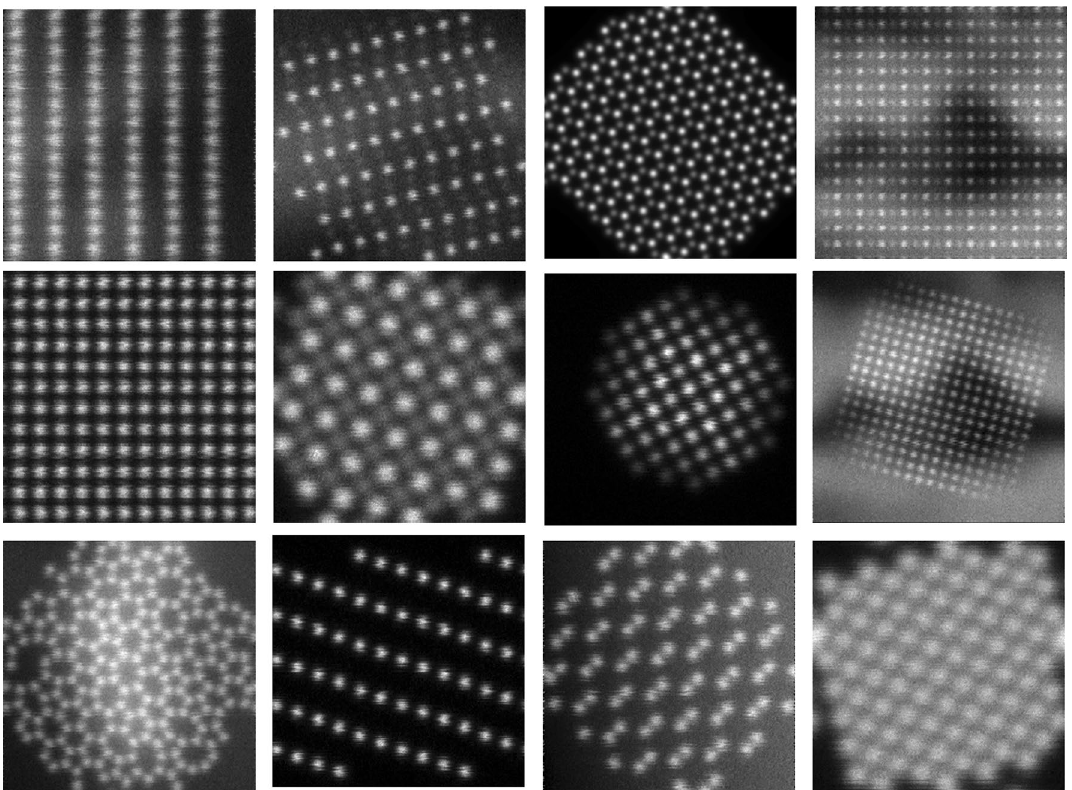
Figure 2. A few examples of the synthetic ADF-STEM images from the training